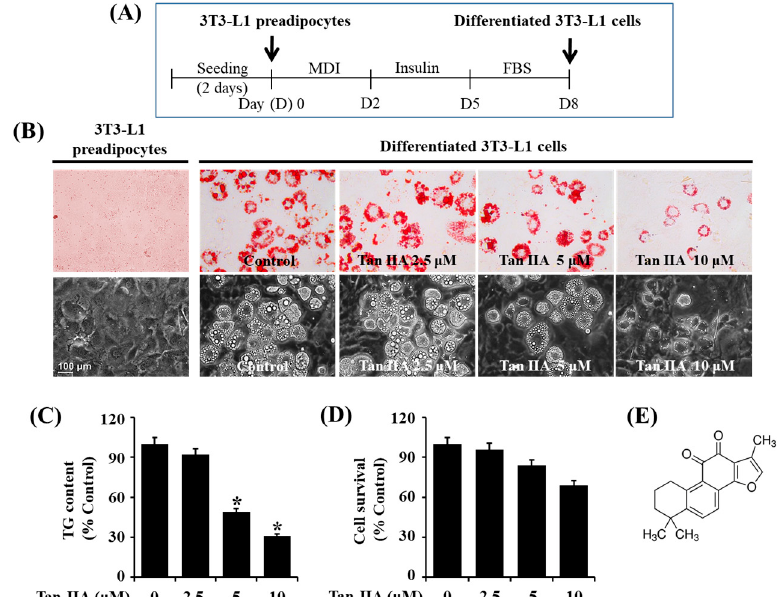
Figure 1. Effects of tanshinone IIA on lipid accumulation, triglyceride (TG) contents, and cell growth during 3T3-L1 preadipocyte differentiation. ( A ) Timetable for 3T3-L1 preadipocyte differentiation; ( B ) measurement of the cellular lipid (lipid droplets) in 3T3-L1 preadipocytes (undifferentiated) or differentiated adipocytes on day 8 of differentiation (D8) by Oil Red O staining. Phase-contrast images of the cells were also taken after the treatment (lower panels in B); ( C ) quantification of the cellular TG contents in tanshinone IIA-treated 3T3-L1 preadipocytes on D8 by AdipoRed assay. Values are mean ± SE of data from three independent experiments with three replicates. * p < 0.05 vs. control (no chemical); ( D ) 3T3-L1 preadipocytes were grown under the above-mentioned 3T3-L1 preadipocyte differentiation condition in Figure 1A. On day 8 (D8), the tanshinone IIA-treated 3T3-L1 preadipocytes, which cannot be stained with trypan blue dye, was counted under microscope. The cell count assay was done in triplicates. Data are mean ± SE of three independent experiments. * p < 0.05 vs. control (no chemical); ( E ) is the chemical structure of tanshinone IIA.